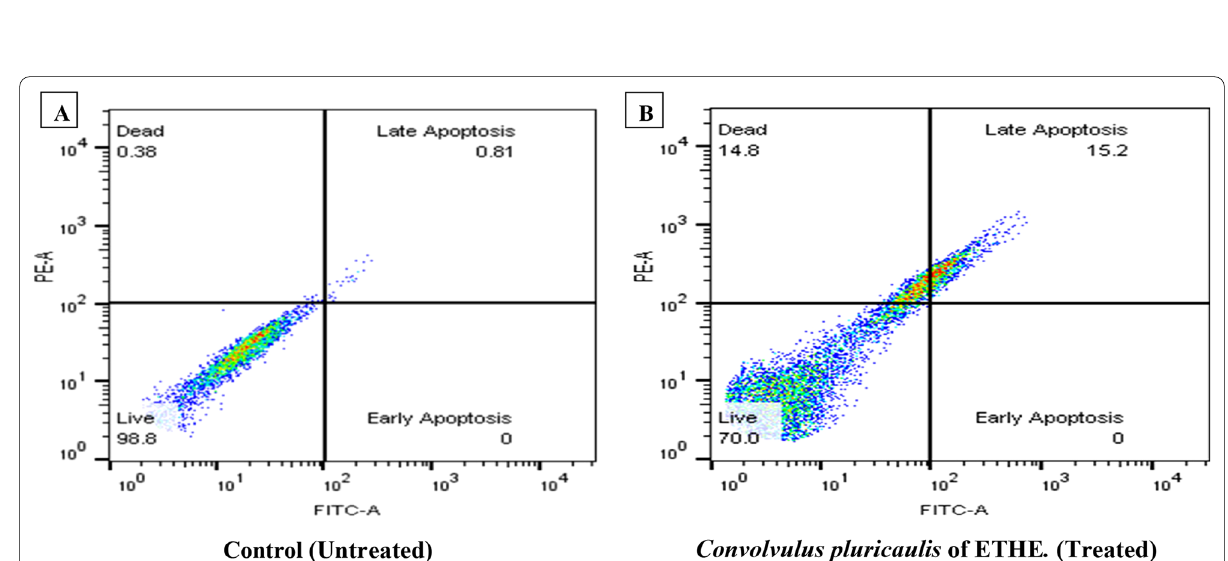
Fig. 5 Flow-cytometric analysis of ( A ) Control and ( B ) Convolvulus pluricaulis of ETHE and Annexin V-FITC & PI double labeling were used to trigger apoptosis in Hep G2 cells. Results represent both panels indicate (Annexin PI ) late apoptosis in the upper right quadrant/(Q2). The quadrant on lower left represents viable cells/(Q4). The upper left quadrant shows + necrosis (Annexin /PI ) − +